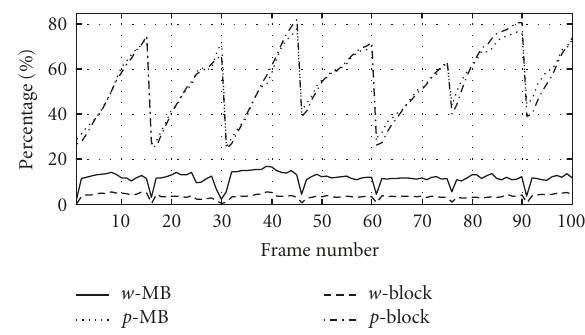
Figure 11: Percentage of the macroblock types and the block types during the VET